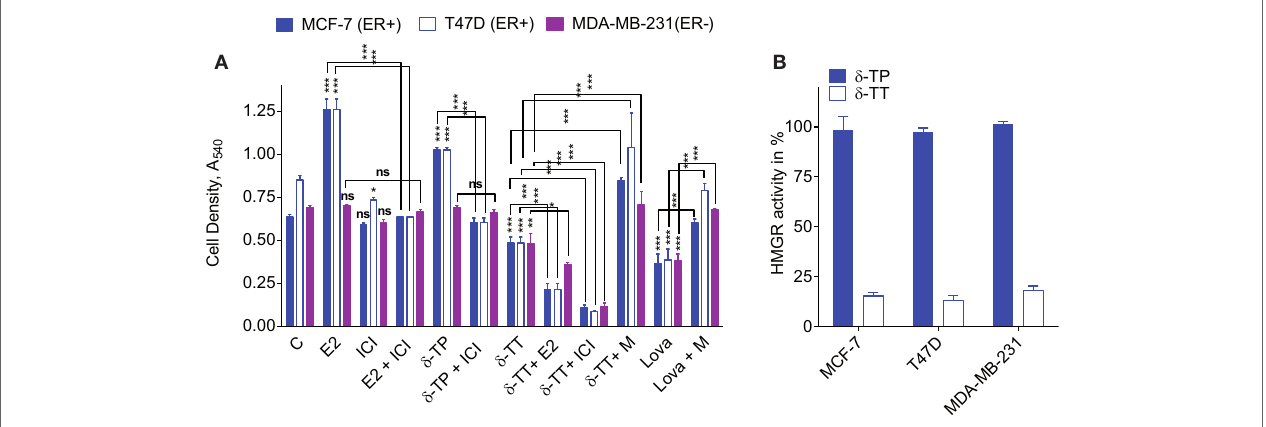
FigUre 4 | effect of tocol on er( + ) and er( − ) Bc cell proliferation and hMg-coa reductase activity . (a) Effect of δ -tocols on estrogen and non-estrogen- regulated growth of MCF-7, T47D, and MDA-MB-231 cells. Cells were treated with solvent vehicle (C), 1 nM 17 β estradiol (E2), or 500 μ M δ -TP in the presence or absence of 1 μ M ICI. Alternatively, cells were treated with 500 μ M δ -TT in the presence or absence of 100 nM E2, 1 μ M ICI, or 5 mM mevalonolactone (M). Cells were also treated with 30 μ M lovastatin (Lova) in the presence or absence of 5 mM M, as described in Section “Materials and Methods.” Values are shown as means and vertical bars represent SEM. The data were analyzed by two-way ANOVA, followed by Bonferroni post hoc test. *** P < 0.001, ** P < 0.01, and * P < 0.05 in comparison with control or bare-linked specific control. Ns: not significant. (B) Effect of δ -TT on hydroxymethylglutaryl coenzyme A reductase (HMGR) activity in MCF-7, T47D, and MDA-MB-231 cells. Cells were treated with 500 μ M δ -TT or δ -TP, as described in Section “Materials and Methods.” Results are reported as the percentage of HMGR activity compared to solvent vehicle-treated cells. Data shown are the mean values ± SEM from three independent experiments performed in